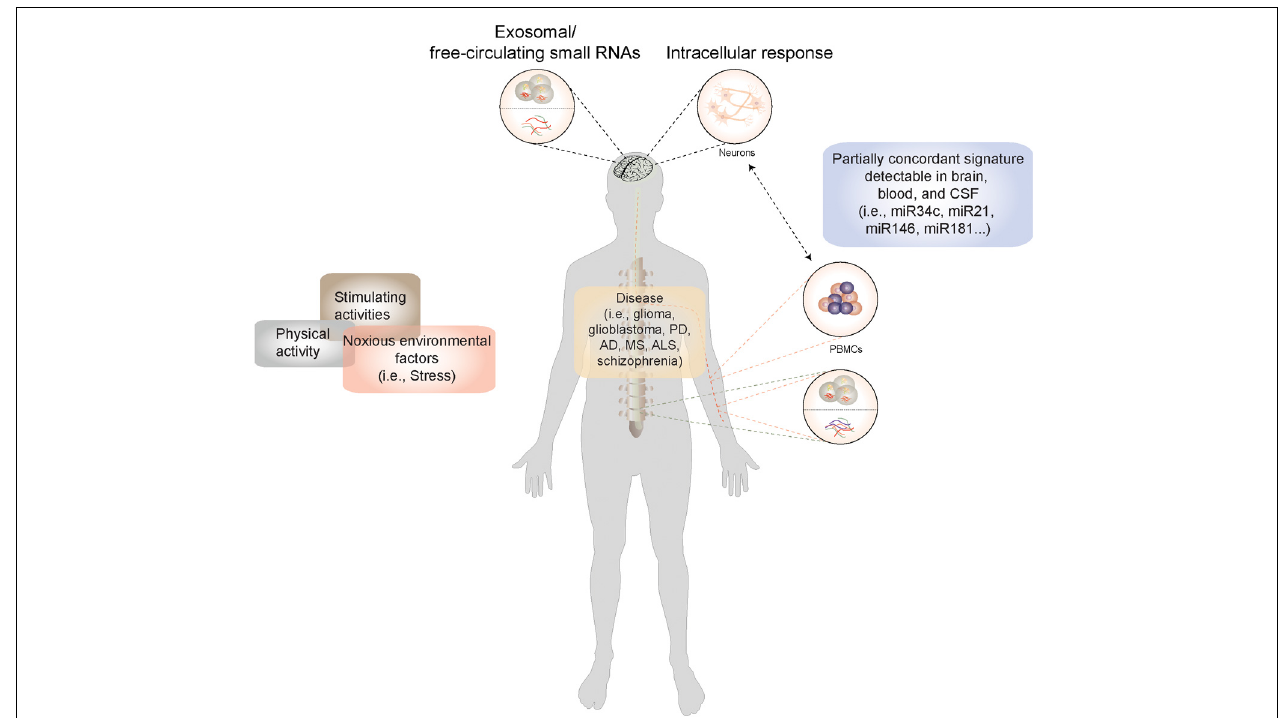
FIGURE 1 | A model for miRNA-based biomarker development: Disease-causing factors impact the brain both directly and indirectly (via immune and other cells), eliciting changes in gene and microRNA expression patterns. Many of these stimuli concurrently exert their influence on non-neuronal cells, where they also elicit a response. In CNS diseases, in the absence of direct access to diseased tissue, microRNA expression patterns from